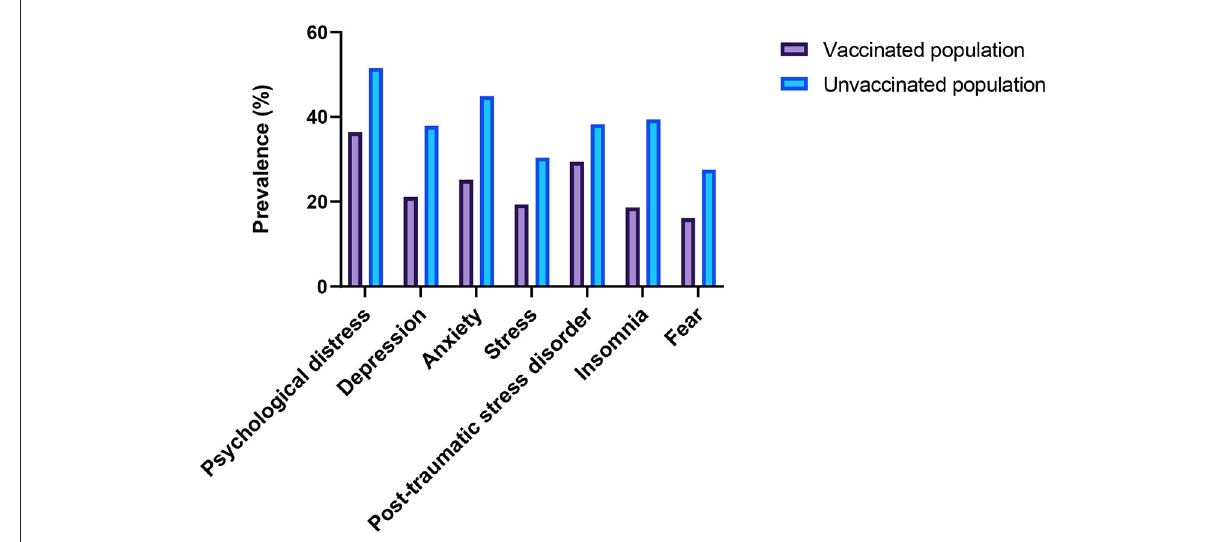
FIGURE1 Prevalence of psychological effects among the vaccinated and unvaccinated populations against COVID-19